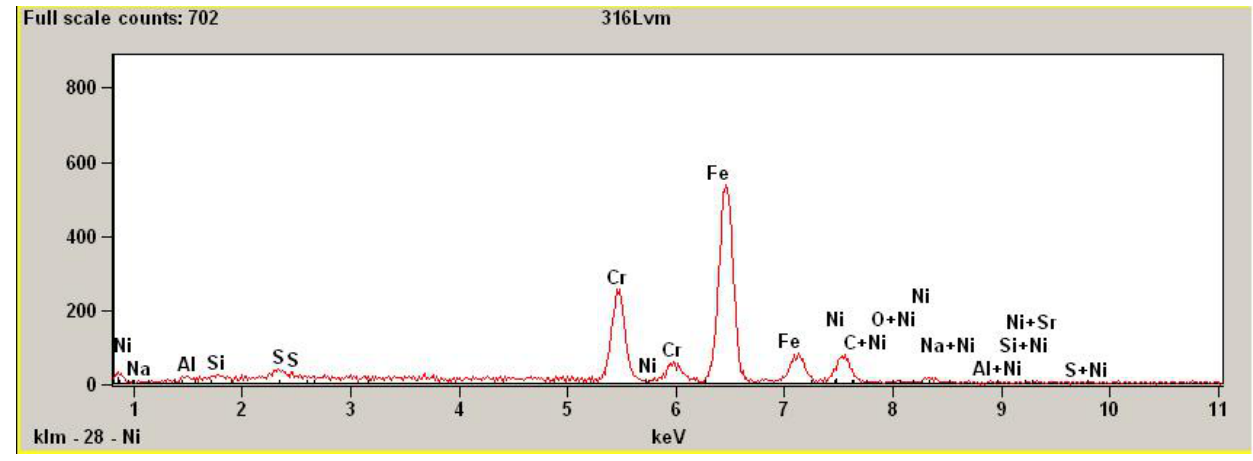
Figure 6. EDS results of 316L SS surface after magnetoelectropolishing (MEP), (save